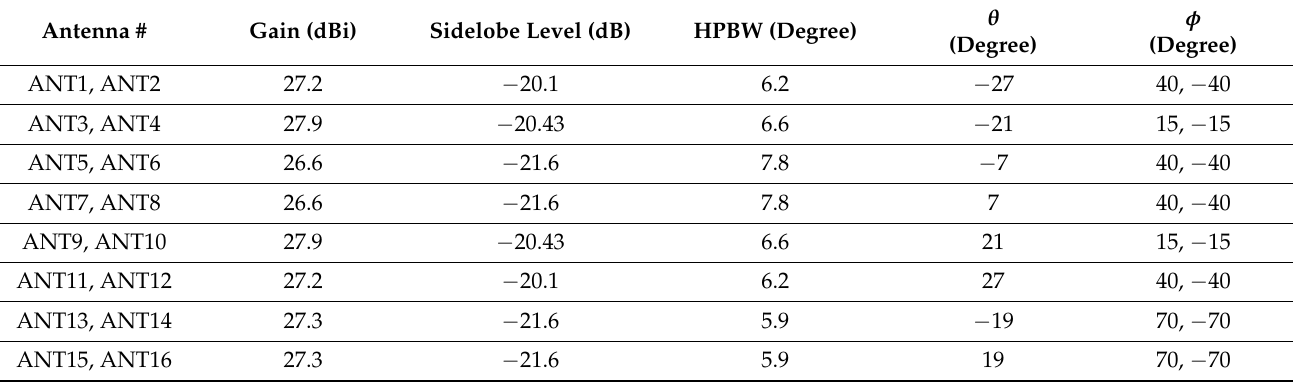
Table 1. The performance of the millimeter-wave beamforming of 16 switchable antennas.